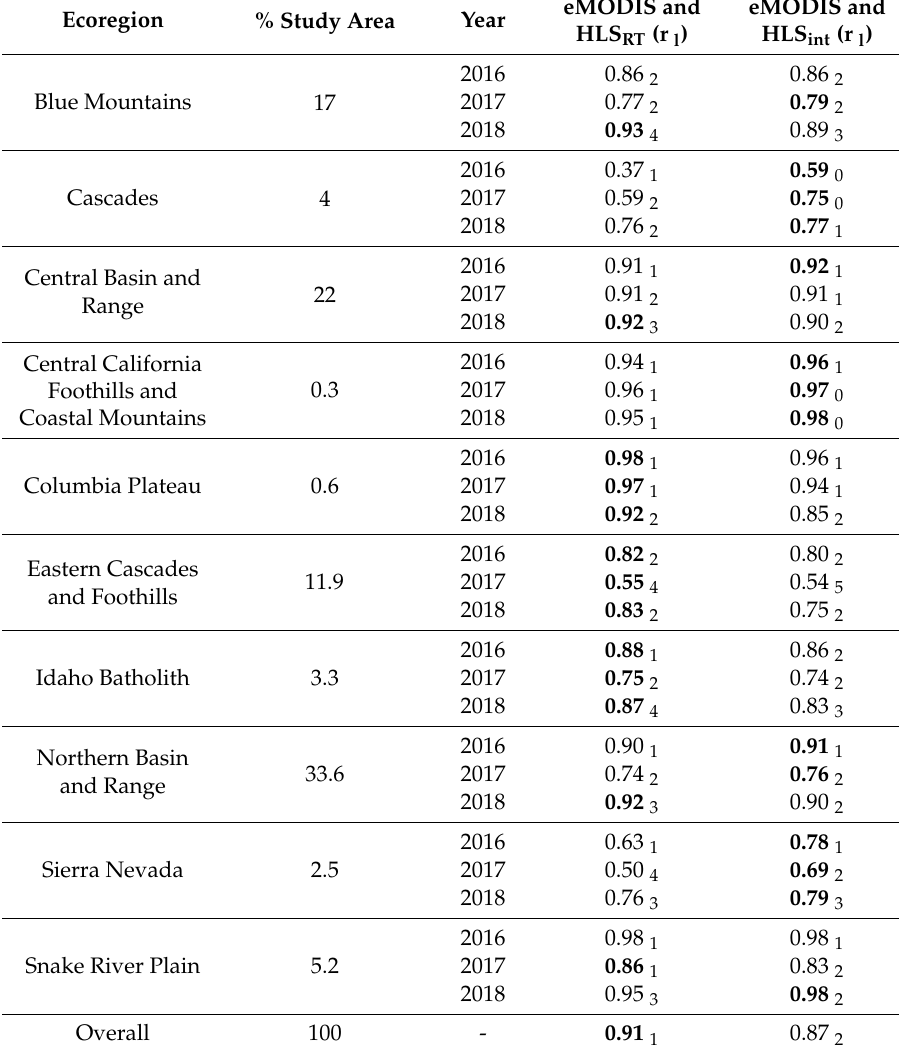
Subscript indicates lag in weeks. Bold values indicate r ’s greater than adjacent r